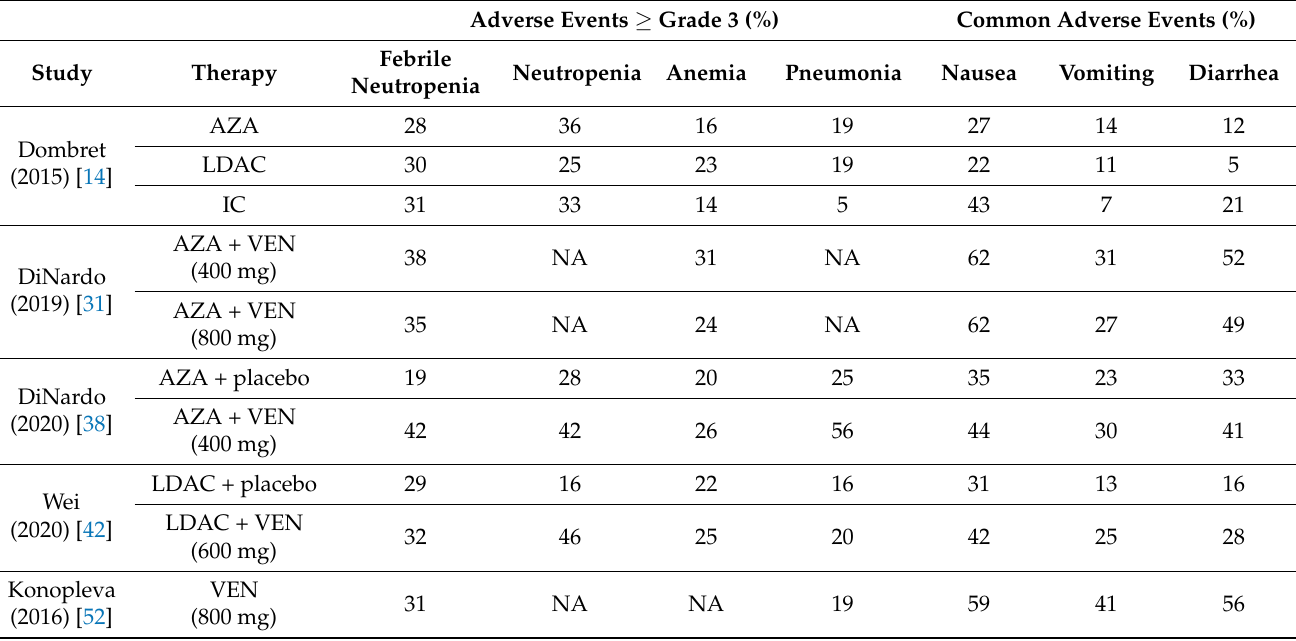
Table 2. Adverse events > grade 3 and common adverse events for AML